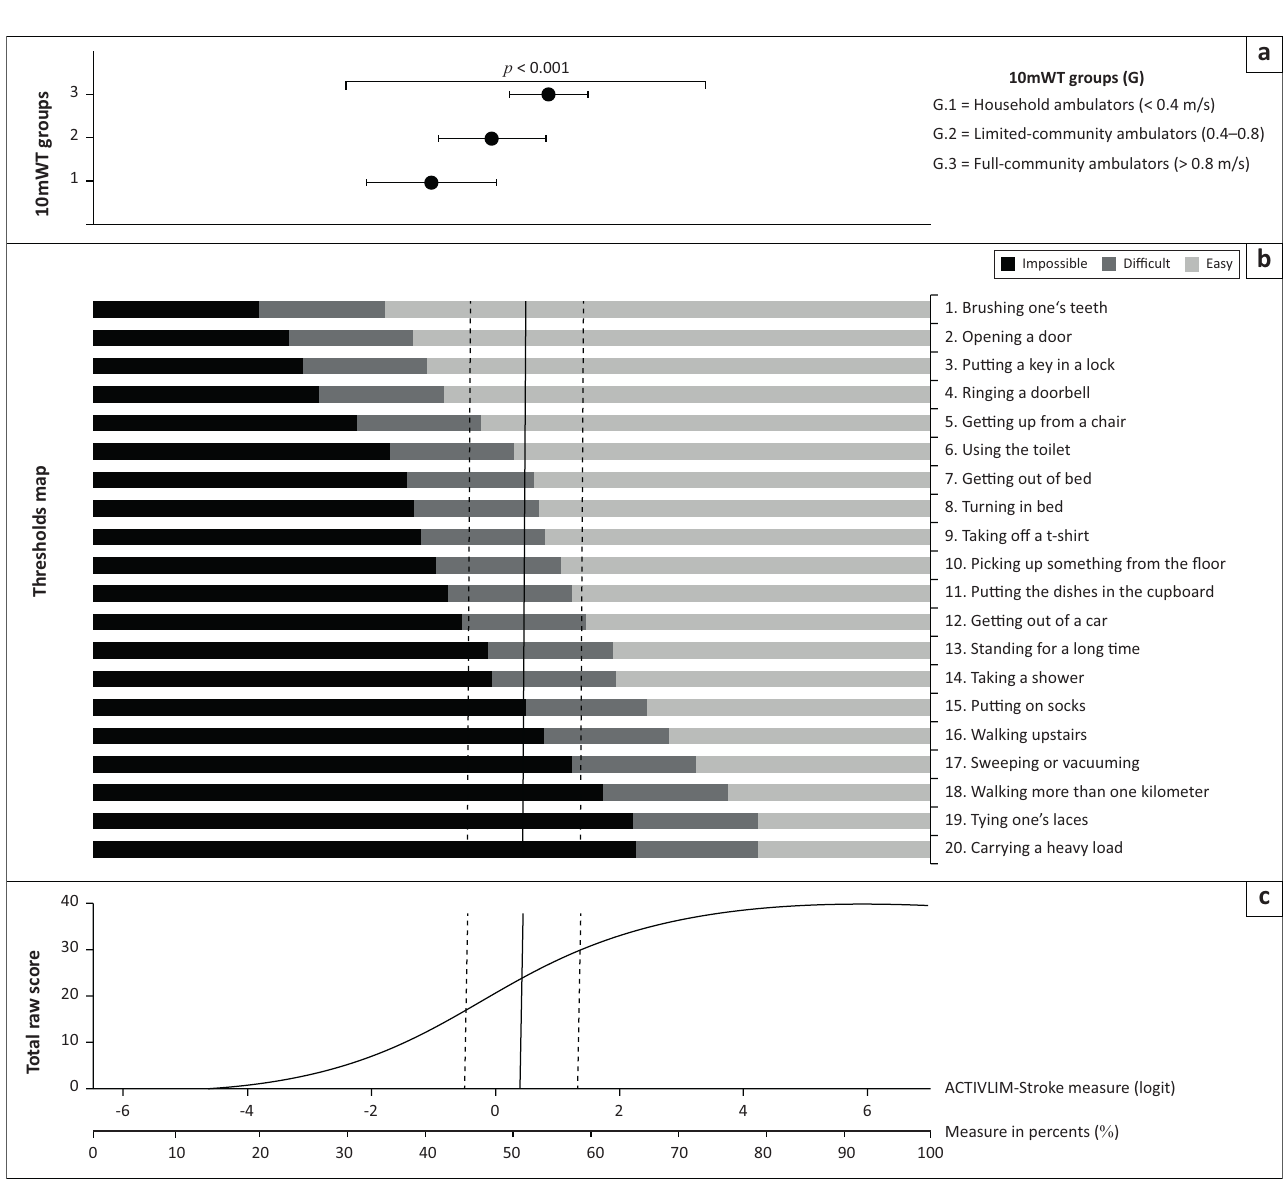
FIGURE 3: Graph showing activity limitation